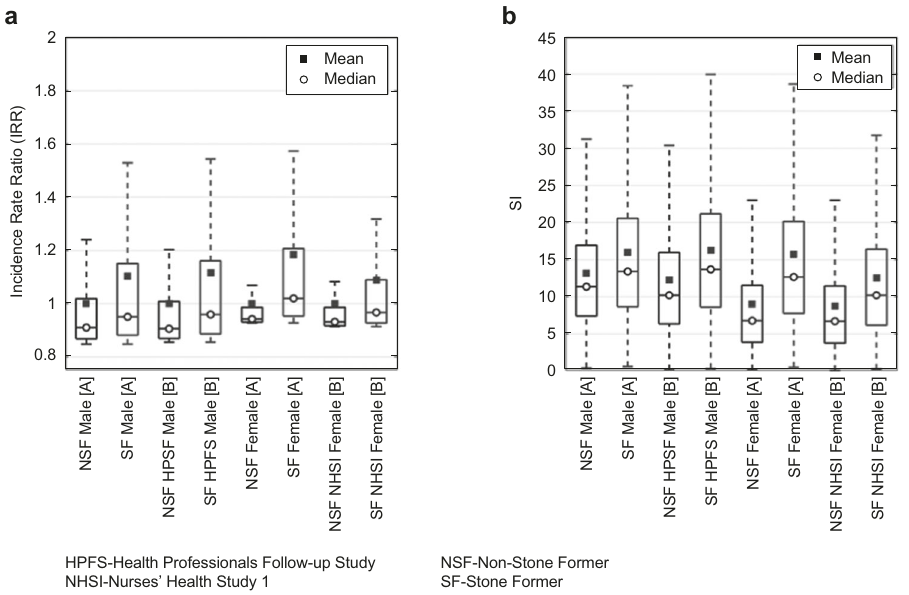
Fig. 2 Characterization of numerical predictions for known stone formers (SF) and non-stone formers (NSF) population urine chemistries. The model ’ s ability to predict differences in SF and NSF populations is illustrated by contrasting male and female stone formers (SF) and non- stone formers (NSF) population urine chemistries from case and control sources [A] 60 and [B] 45 . In a , each numerically predicted IRR distribution is normalized using the case and control pair ’ s control group mean predicted IR as the reference. In b , the SI of each case and control pair, as determined by JESS, is presented. SI values in b are not normalized by the control mean of each